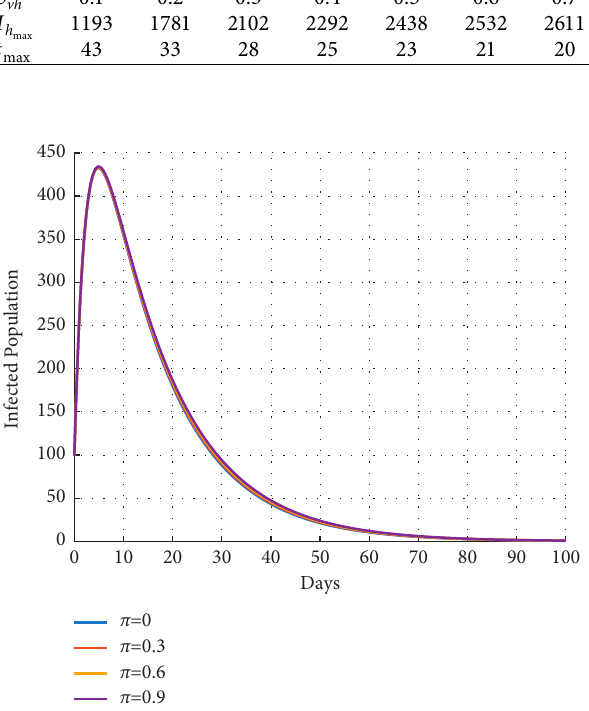
Figure 8: Evolution of the epidemic spreading in the vector population for various values of the vertical transmission rate π . Mosquito-to-human interaction is set at a �